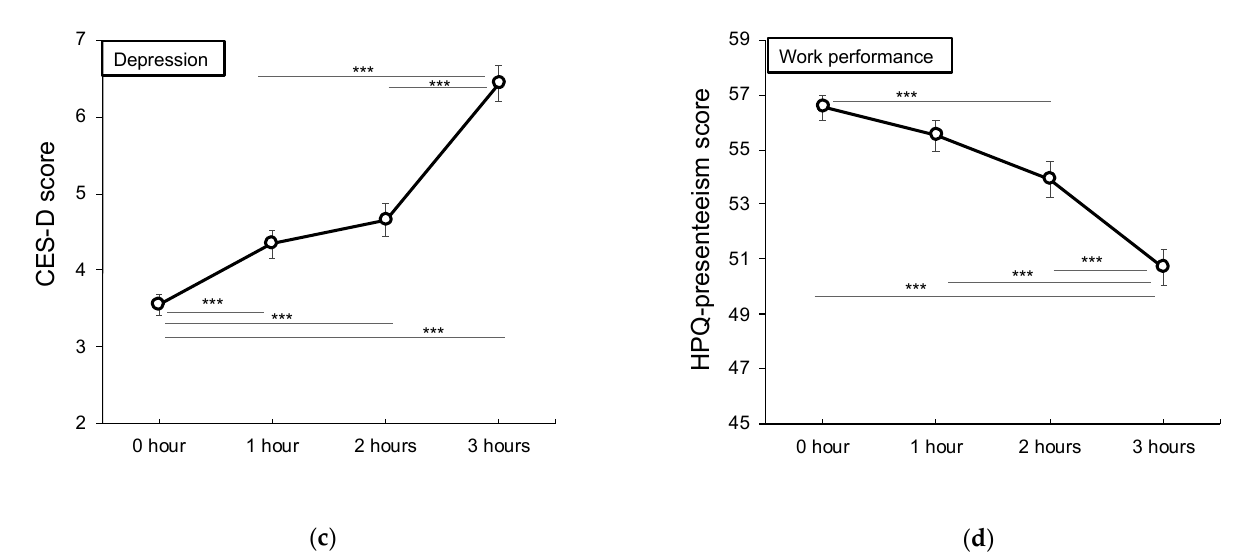
Figure 2. Association of sleep duration and Sleep Debt Index with depression and performance. Upper panels ( a , b ): Relationship between absolute sleep duration and each scale; bottom panels ( c , d ): Relationship between SDI and each scale. Error bars indicate the standard errors. CES-D, Center for Epidemiological Studies-Depression Scale; HPQ presenteeism, WHO Health and Work Performance Questionnaire-presenteeism subscale; SDI, sleep debt index. *** p < 0.001.